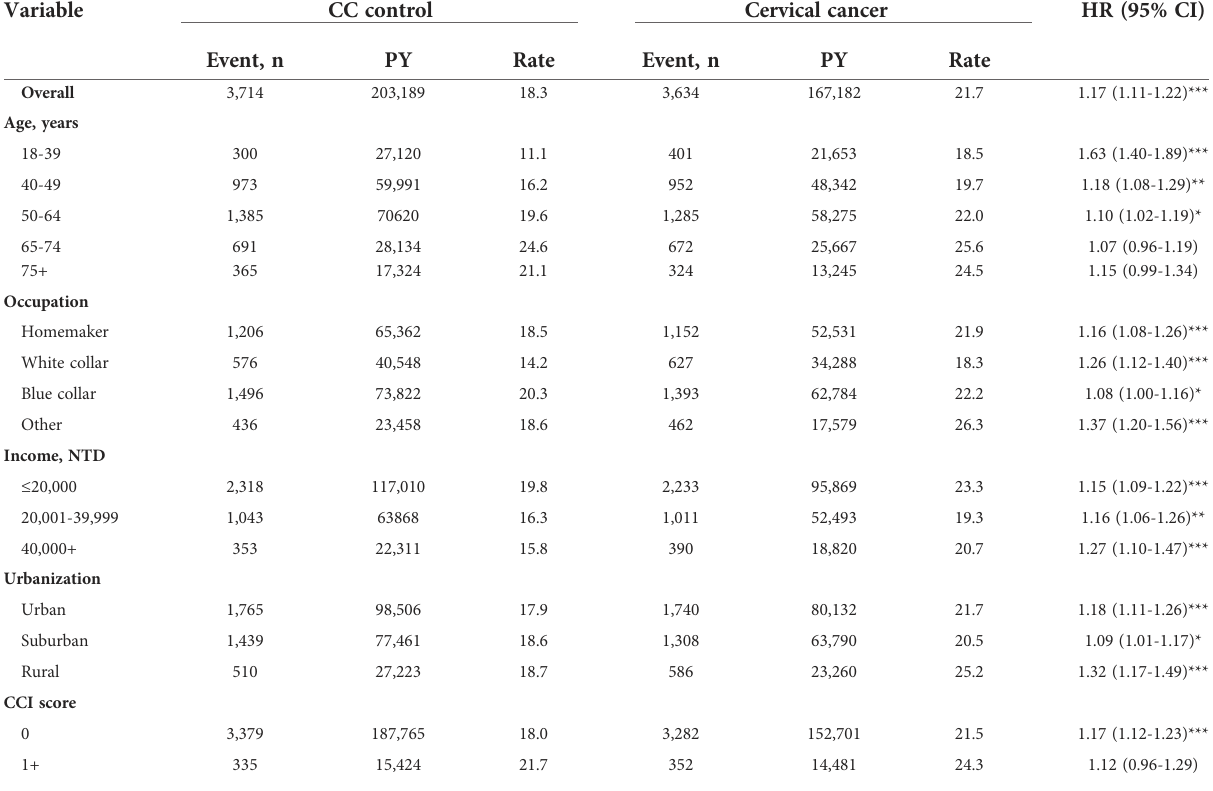
TABLE 5 Combined incidence of anxiety and depression and cervical cancer cohort to comparison cohort adjusted cohort hazard ratio by age, occupation, income, urbanization, and Charlson comorbidity index score.